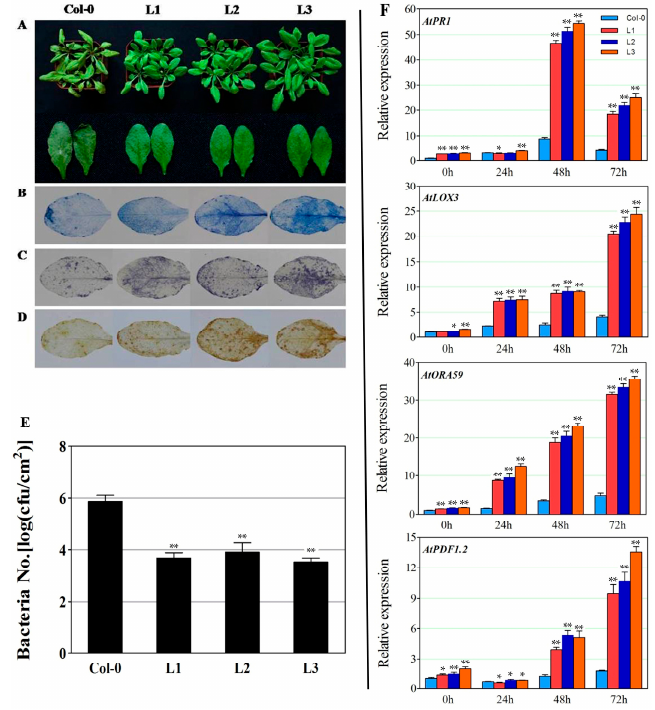
Figure 5. Overexpression of VaERF20 in A. thaliana conferred enhanced disease responses to Pst DC3000 inoculation. ( A ) The disease symptoms on transgenic A. thaliana and Col-0 leaves three days post-inoculation (dpi). ( B – D ) Histochemical staining for cell death ( B ), O 2 − ( C ) and H 2 O 2 ( D ) accumulation, respectively. Transgenic A. thaliana and Col-0 were observed in three independent experiments with 5–10 leaves in each. ( E ) Bacterial population assays in infected transgenic A. thaliana and Col-0 leaves at 3 dpi. Data represent the means± standard deviation from three independent experiments. Asterisks indicate statistical significance (** p < 0.01, one-way ANOVA) between transgenic A. thaliana and Col-0. ( F ) Expression analysis of defense-related genes in transgenic A. thaliana lines and Col-0 plants at 0, 24, 48, 72 hpi following inoculation with Pst DC3000. Data represent the means ± standard deviation from three independent experiments. Asterisks indicate statistical significance (* 0.01 < p < 0.05, ** p < 0.01, one-way ANOVA) between transgenic A. thaliana and Col-0 samples.